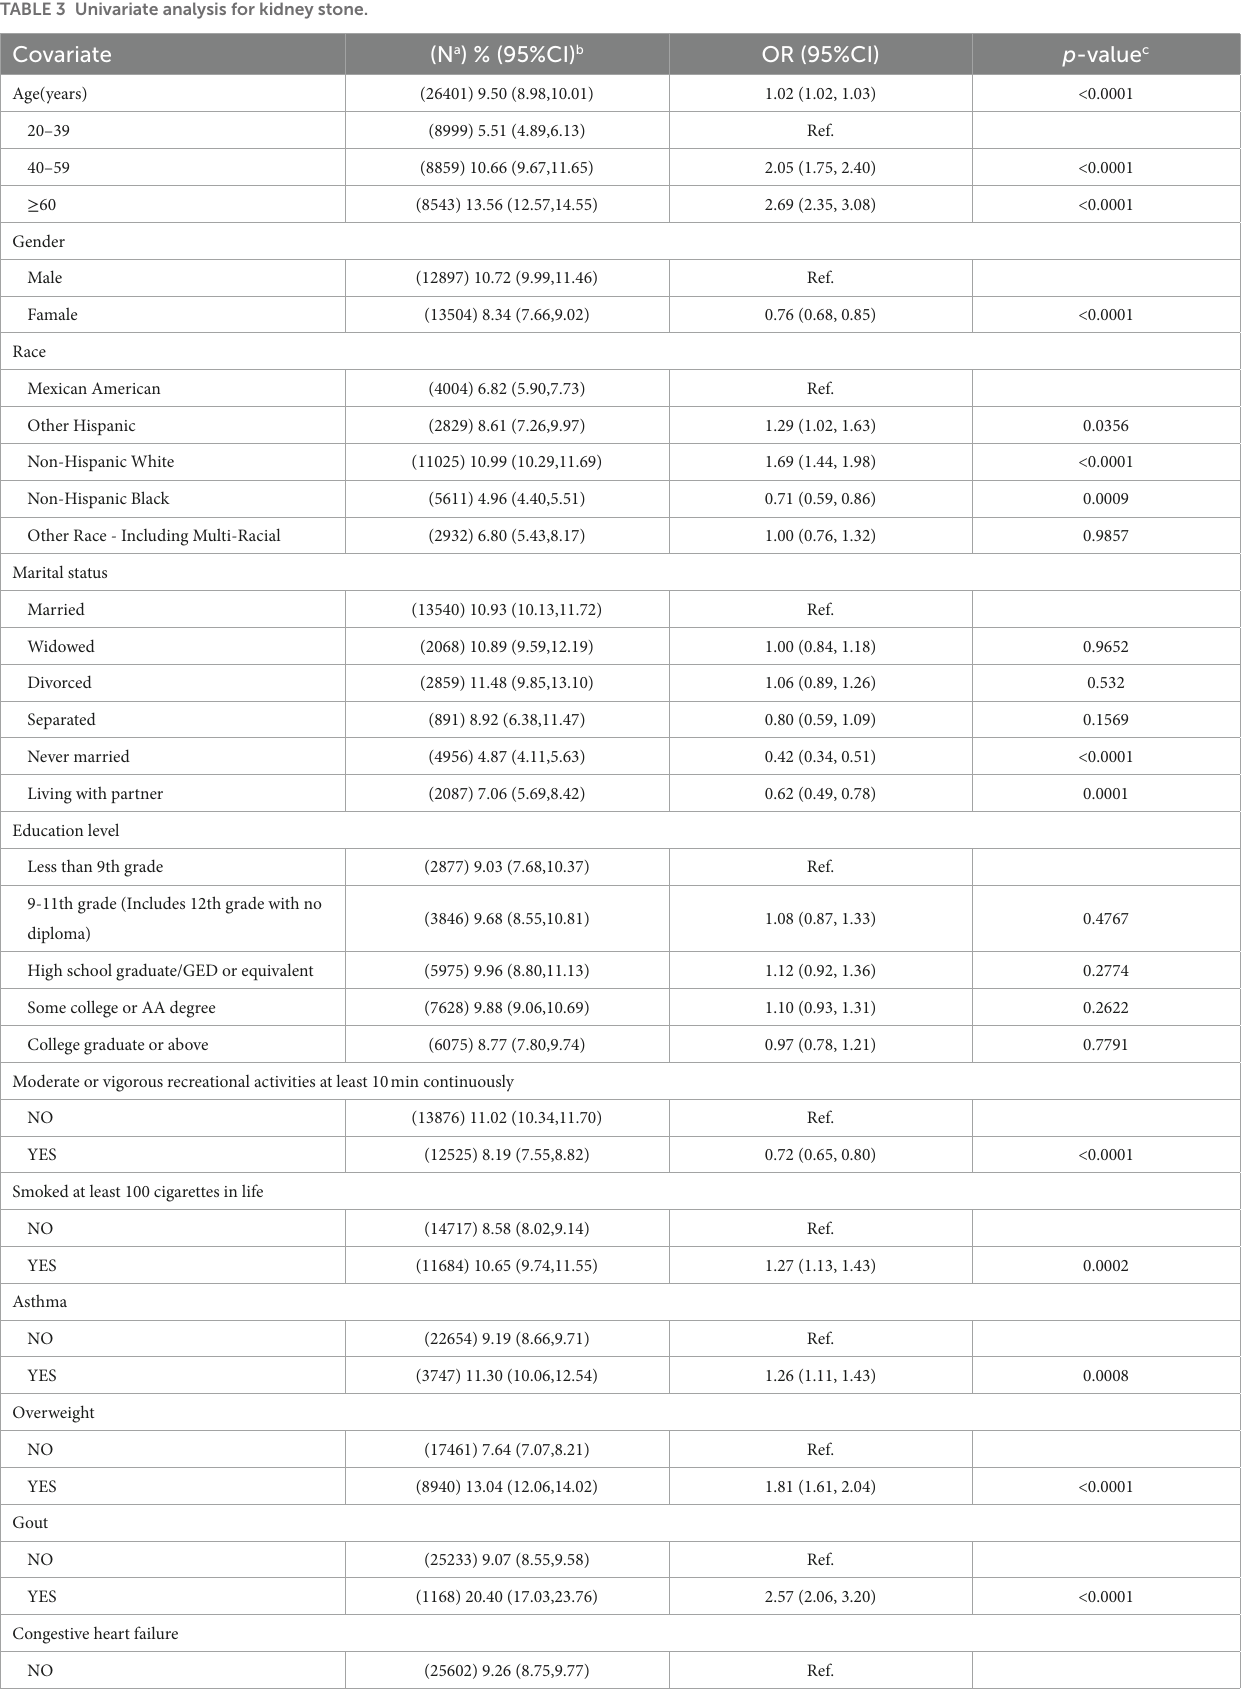
TABLE 3 Univariate analysis for kidney stone.